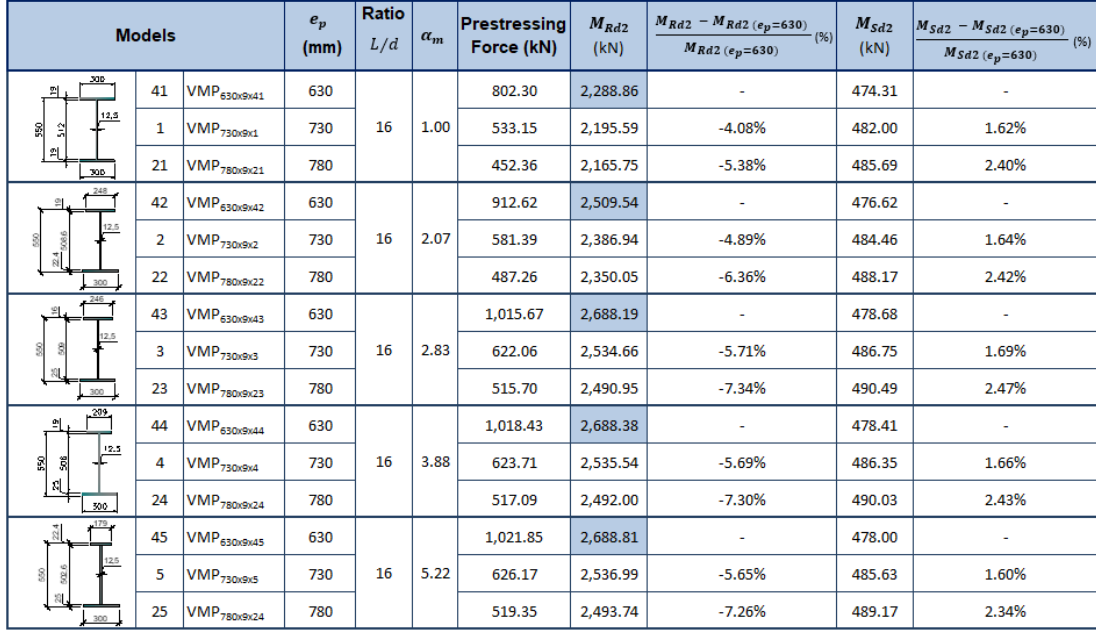
Figure 8. i a2 versus monosymmetry degree (